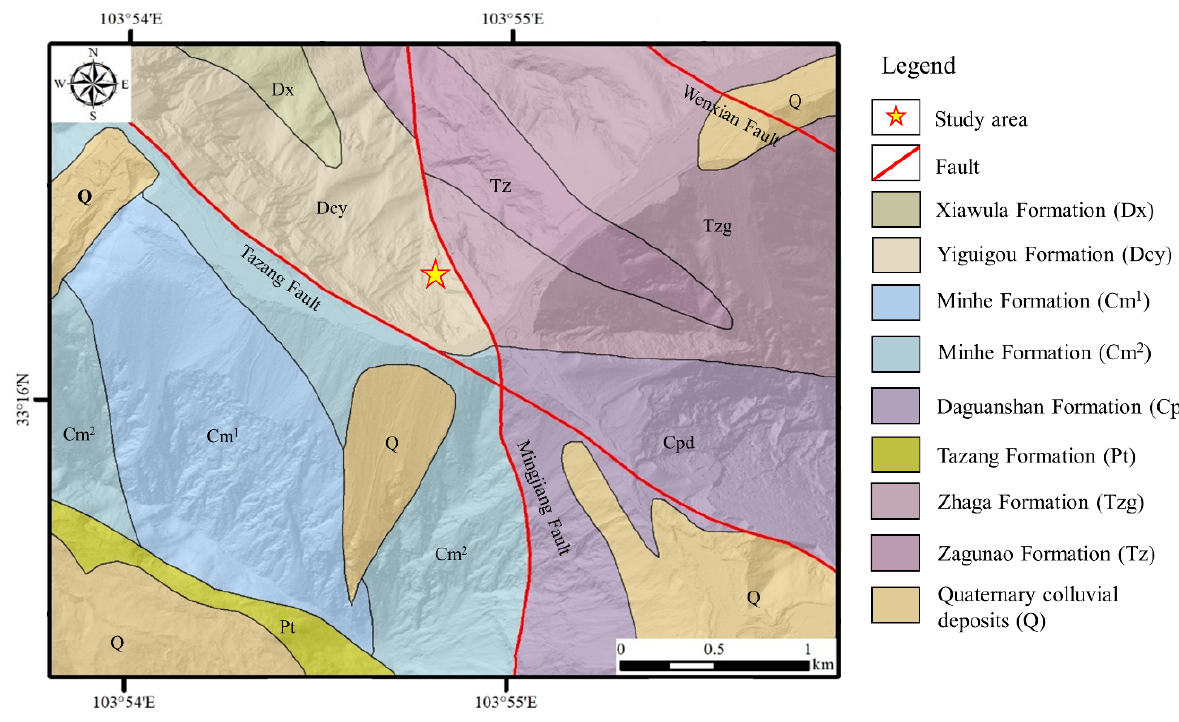
Figure 2. Geological map of the study area.